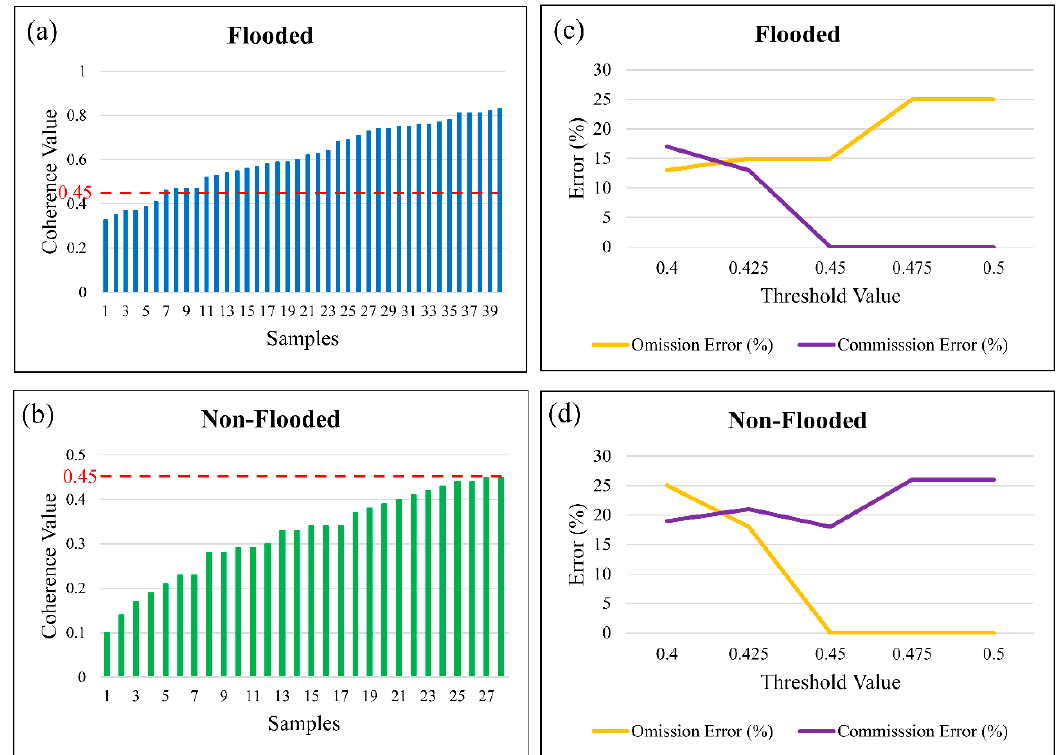
Figure 4. Optimum coherence threshold selection for the flooded and non-flooded vegetated wet- lands: coherence values for the ( a ) flooded and ( b ) non-flooded wetland samples; omission and commission errors of different threshold values for the ( c ) flooded and ( d ) non-flooded wetlands. The red lines in ( a , b ) indicate the selected optimum threshold value (i.e.,